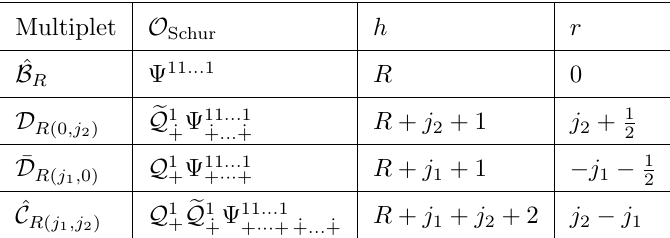
Table 4 . Summary of the appearance of Schur operators in short multiplets of the N = 2 super- conformal algebra, sl (4 j 2). The superconformal primary in a supermultiplet is denoted by (cid:9). There is a single conformal primary Schur operator O Schur in each listed superconformal multiplet. The holomorphic dimension h and gl (1) r charge r of O Schur are given in terms of the quantum numbers ( R; j 1 ; j 2 ) that label the shortened multiplet (left-most